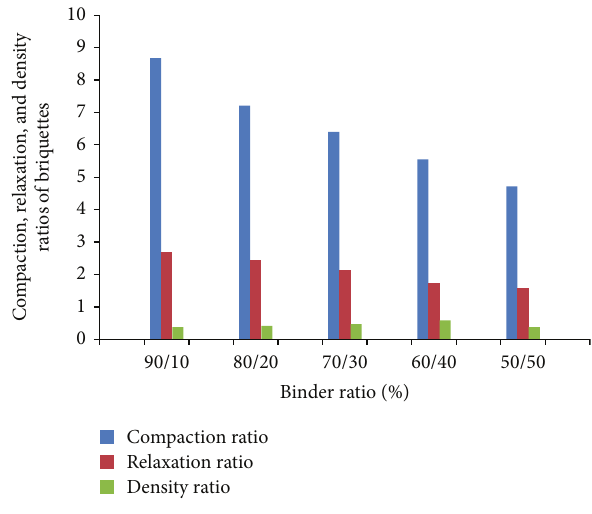
Figure 2: Effect of binder on compaction, relaxation, and density ratios of